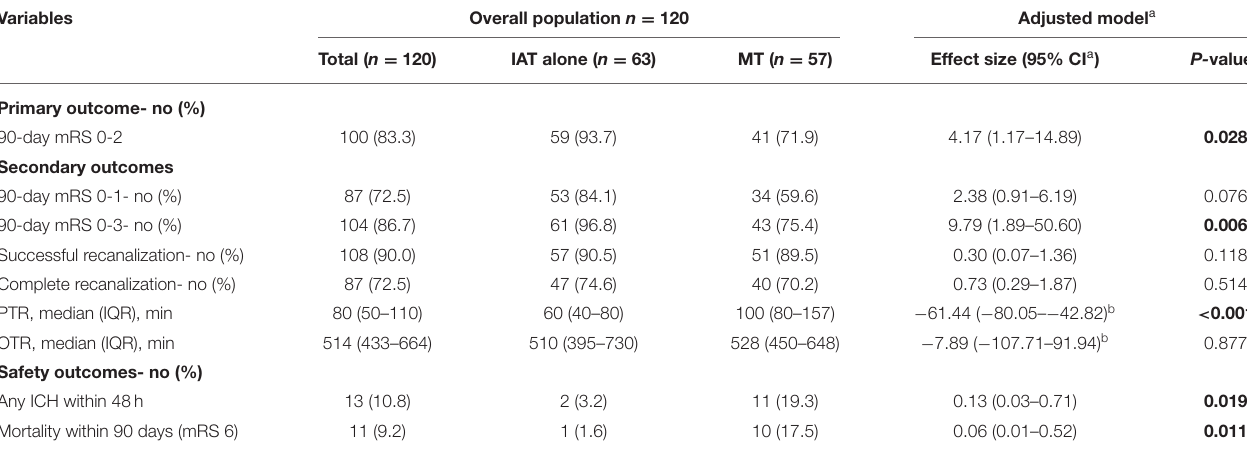
TABLE 3 | Sensitivity analysis: comparison of outcomes between IAT alone and MT groups with adjustment for the propensity score.